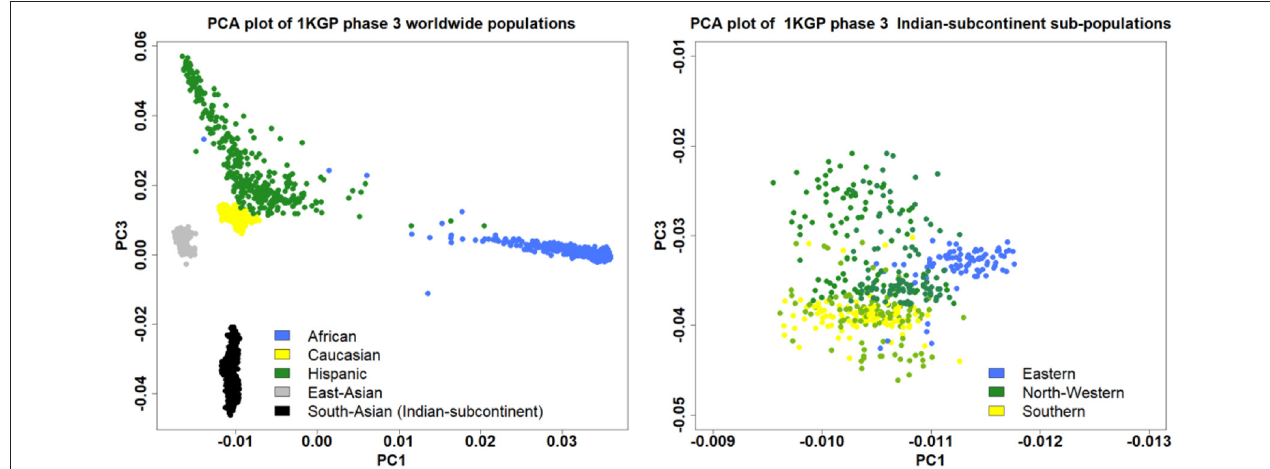
FIGURE 3 | The PCA plot using the phase 3 1,000 Genomes Project showing the distribution of the South Asian population among the worldwide populations (left), and sub-populations from different regions of the Indian subcontinent (right).